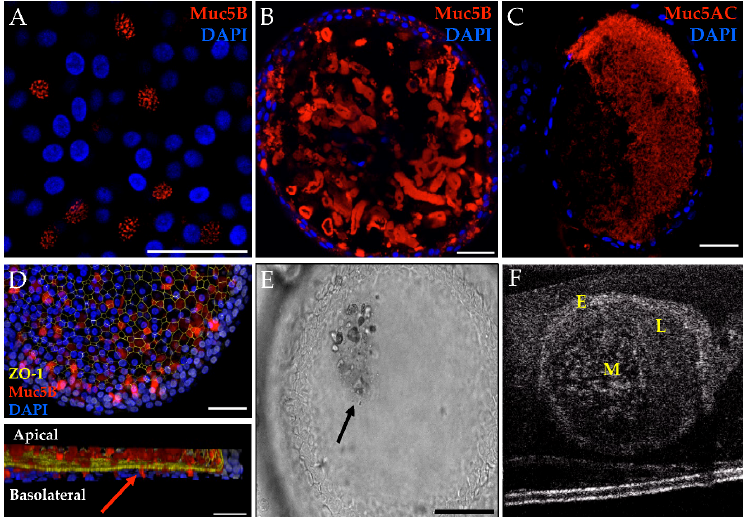
Figure 3. Mucus characteristics in HNE organoids, representative findings from CF and non-CF organoids are shown. ( A ) MUC5B granules in G551D/N1303K organoid. Scale = 50 µm. ( B ) Muc5B whole-mount IF showing a bundled mucin pattern in F508del/R117H-5T organoid. Scale = 50 µm. ( C ) MUC5AC fixed cross-section showing a diffuse mucin pattern in a non-CF organoid. Scale = 50 µm. ( D ) Top panel is the maximum projection of the 3-D hemisphere in the bottom panel. MUC5B is seen entering the lumen (arrow) through the apical surface in a non-CF organoid. Scale = 500 µm. ( E ) Brightfield microscopy showing a clump of cellular debris and/or mucus in the lumen in a non-CF organoid. Scale = 100 µm. ( F ) µOCT still of probable mucus in a non-CF organoid. ( E,F ) correspond to Videos S1 and S2 . E = epithelium L = lumen M = mucus.